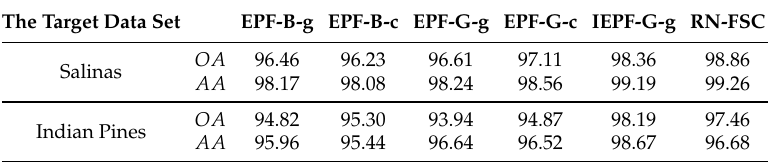
Figure 15. Classification accuracy under different number of labeled samples on three target data sets. Table 11. Classification results of the different methods on Salinas and Indian